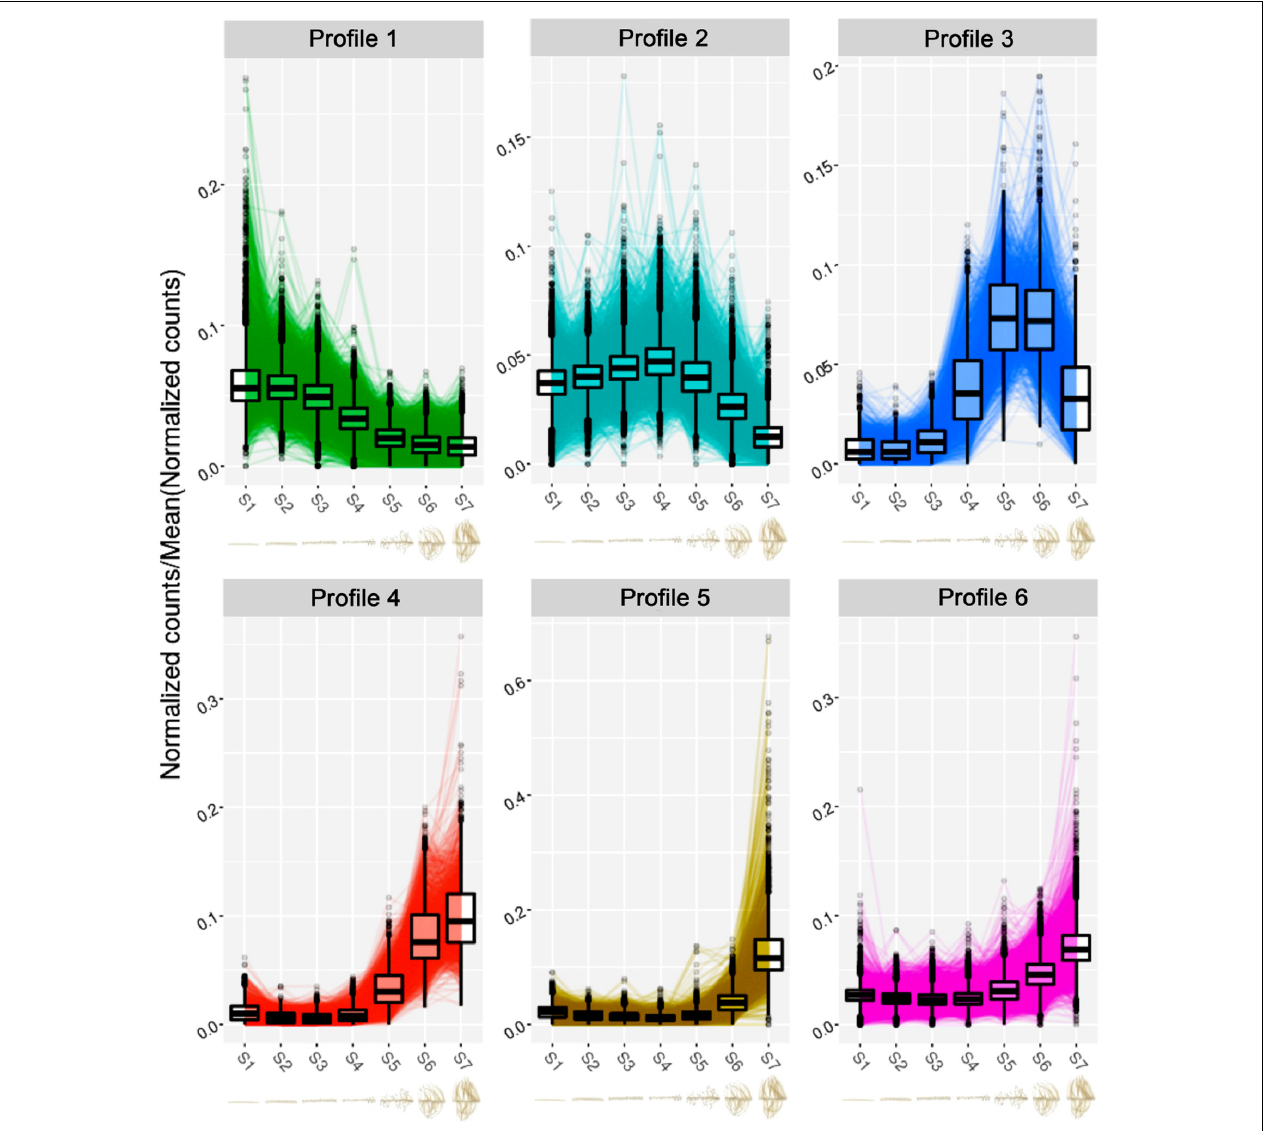
FIGURE 6 | Clustering analysis of the normalized expression profiles of the differentially expressed transcripts between S1 and S7 sections of the RNA-seq experiment. Normalized gene expression profiles come from our previous RNA-seq study (Hufnagel et al., 2020). The clustering was performed with the Coseq package in DIANE (Cassan et al., 2021). The numbers of genes clustered in each gene expression profile are the following: Profile 1: 1,792; Profile 2: 2,129; Profile 3: 411; Profile 4: 482; Profile 5: 584; Profile 6: 1,836. Below each profile, the cluster root sections from S1 to S7 of the RNA-seq analysis are